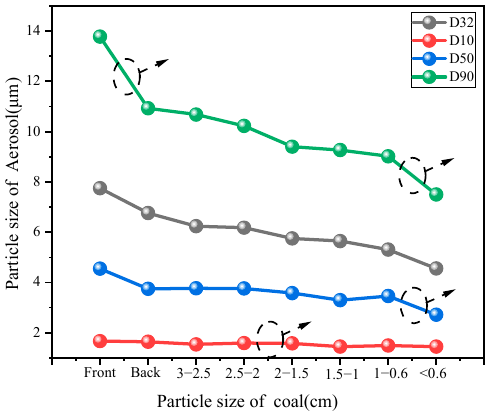
Figure 13. Change of characteristic particle size. In the front and rear of the empty tube test particle size, greater than 10 µ m aerosol particles due to its sedimentation, more easily deposited on the wall, and smaller particle size aerosols are more likely to float outside the tube. From the perspective of particle size classification, the D10 particle size curve does not change with the decrease of coal particle size, indicating that aerosol particles smaller than 2 µ m can pass through the denser coal structure without being affected by it. coal particle size, showing a downward trend. When the coal particle size is less than 0.6 cm, the downward trend is more obvious. At this time, the spatial structure of the coal is denser, allowing aerosol particles to pass through a narrower space, and large aerosol particles are more easily